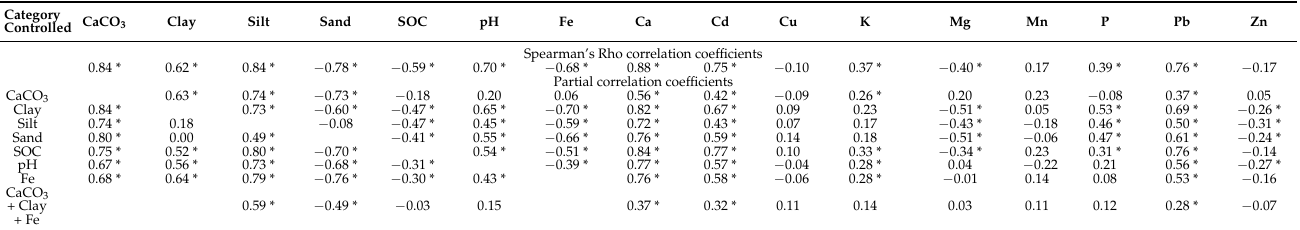
Table 4. Spearman’s Rho correlation coefficients between the first principal component (PC1) of soil reflectance spectra and soil properties (1st row), and the partial correlation coefficients with controlling basic soil